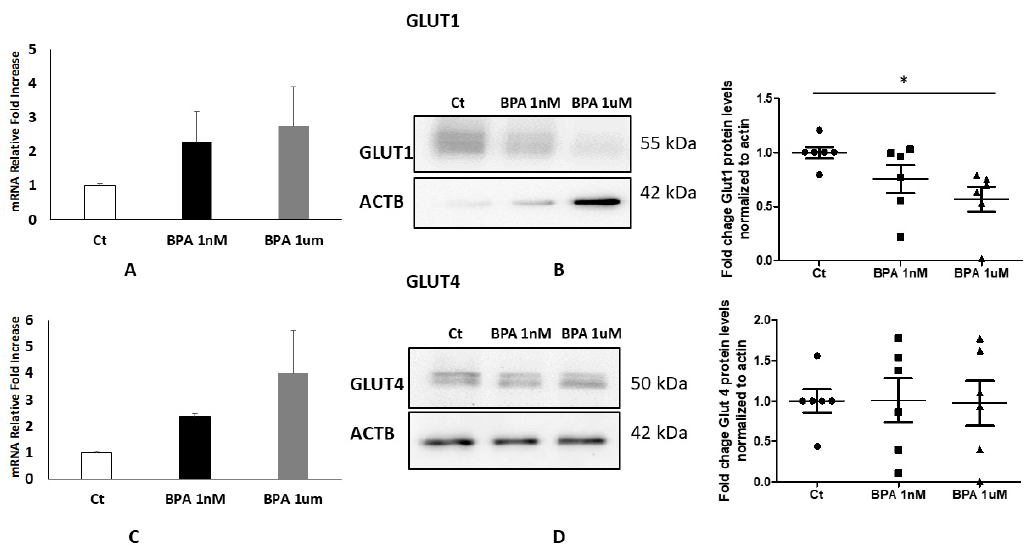
Figure 4. GLUT 1 and 4 expressions ( A , C ) and protein levels ( B , D ) in placenta explants treated with BPA from overweight women. ( A ) Fold Change of GLUT1 mRNA in placental explants from OW women ( n = 5) treated with BPA 1 nM and BPA 1 µ M compared to the vehicle as control. ( B ) Representative WB (left panel) and corresponding densitometry (right panel) of GLUT1 in placental explants from OW women ( n = 6) treated with BPA 1 nM and BPA 1 µ M compared to the vehicle as control. ( C ) Fold Change of GLUT4 mRNA in placental explants from OW women ( n = 5) treated with BPA 1 nM and BPA 1 µ M compared to the vehicle as control. ( D ) Representative WB (left panel) and corresponding densitometry (right panel) of GLUT4 in placental explants from OW women ( n = 6) treated with BPA 1 nM and BPA 1 µ M compared to the vehicle as control. Data are presented as mean ± ES. Significance was determined using a one-way ANOVA and Bonferroni’s test for post hoc comparisons * p < 0.05. Ct: control.